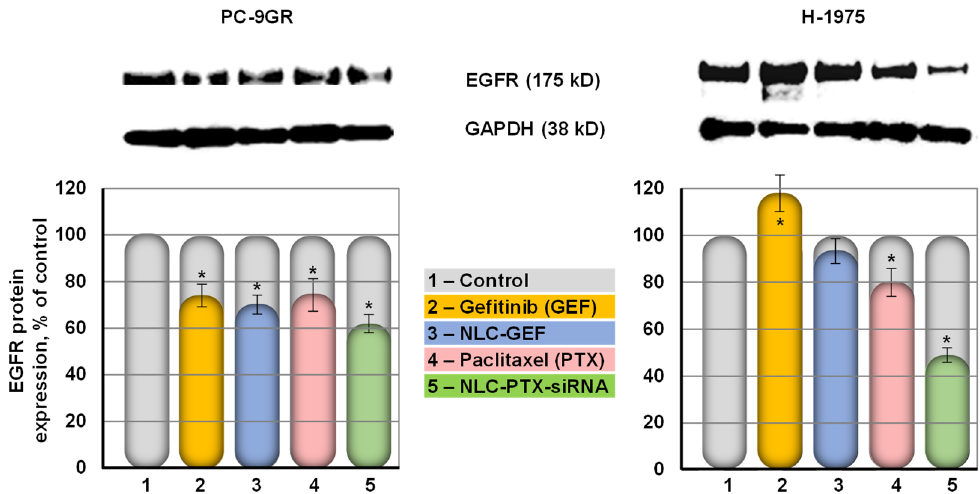
Figure 8. Expression of EGFR protein in human PC9-GR and H-1975 NSCLC cells treated with substances indicated. The expression of EGFR in the control non-treated cells was set to 100%. Top panel shows representative images of Western blots. GAPDH protein was used as internal standard. Means ± SD are shown. * p < 0.05 when compared with untreated control.